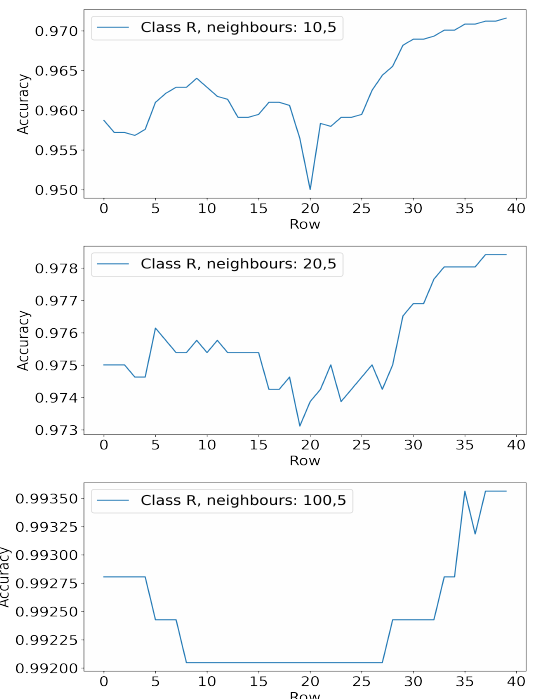
Figure 8: Self-learning MLM accuracy results row-by-row, using each time the whole test